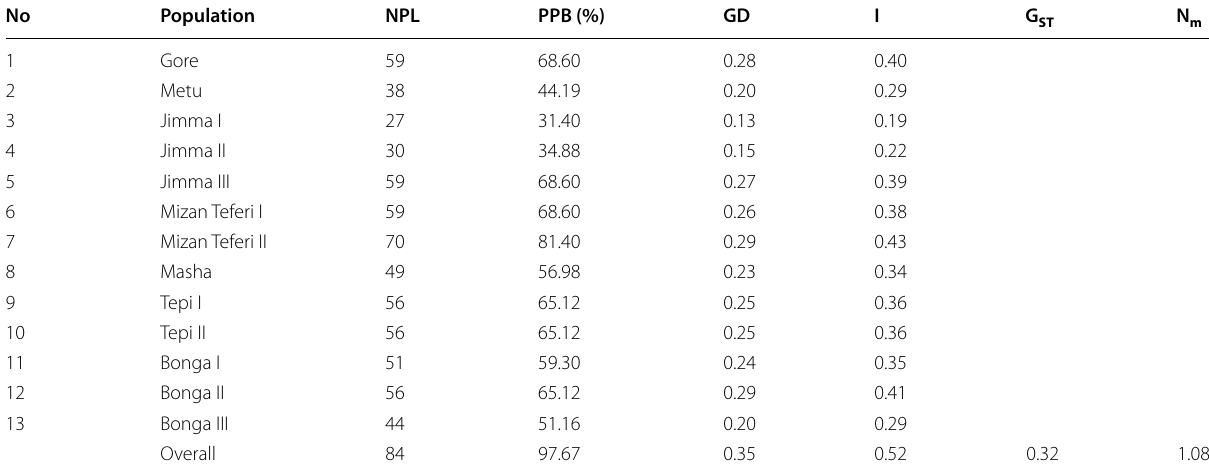
Table 4 Gene diversity estimators for populations of A. corrorima from the southwestern part of Ethiopia based on the results of seven ISSR primers